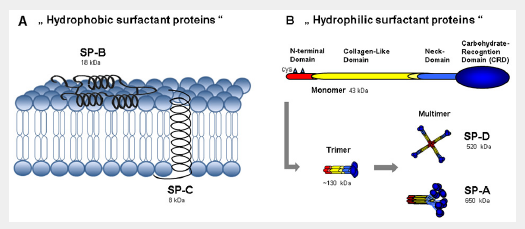
(A) The hydrophobic surfactant proteins B and C are small proteins with α-helices. SP-B is arranged in monolayers or bilayers on the surface of surfactant lipids. Together with SP-C, which is integrated into the phospholipid membrane, they facilitate the spreading and adsorption of lipids into the phospholipid membrane and enhance its stability. Thereby, they greatly contribute to the reduction of surface tension in the alveoli. (B) The hydrophilic surfactant proteins SP-A and SP-D are large multimeric proteins which are assembled from monomers with cysteinyl (cys) residues in the N- terminal domain. These monomers have a characteristic carbohydrate recognition domain in their C-terminal ending, with distinctive binding affinities to glycosylated structures. Trimers